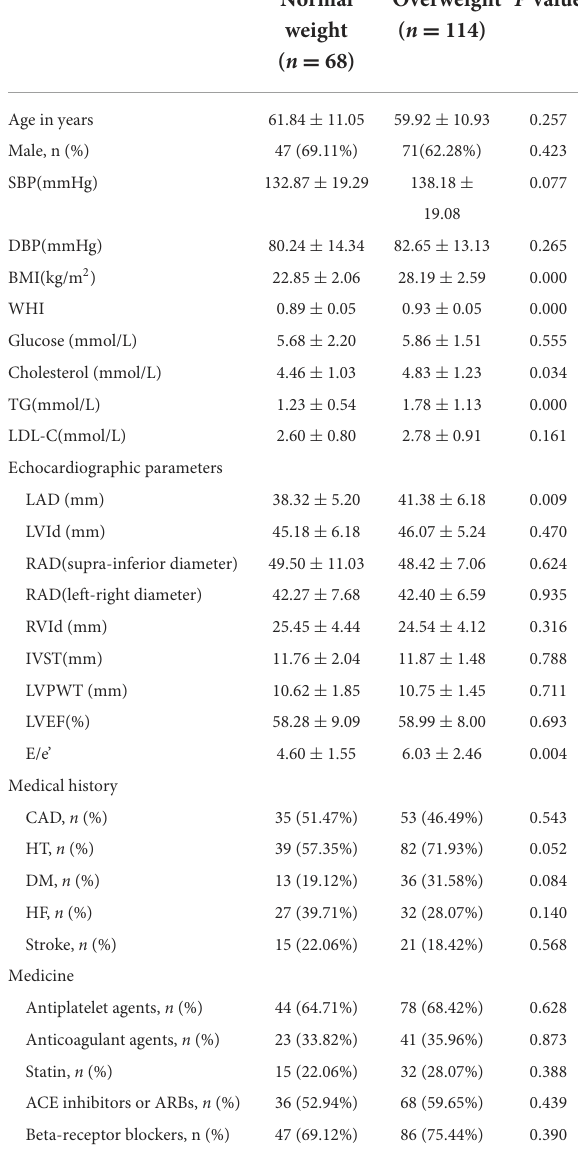
TABLE 1 Baseline characteristics of NVAF patients by BMI